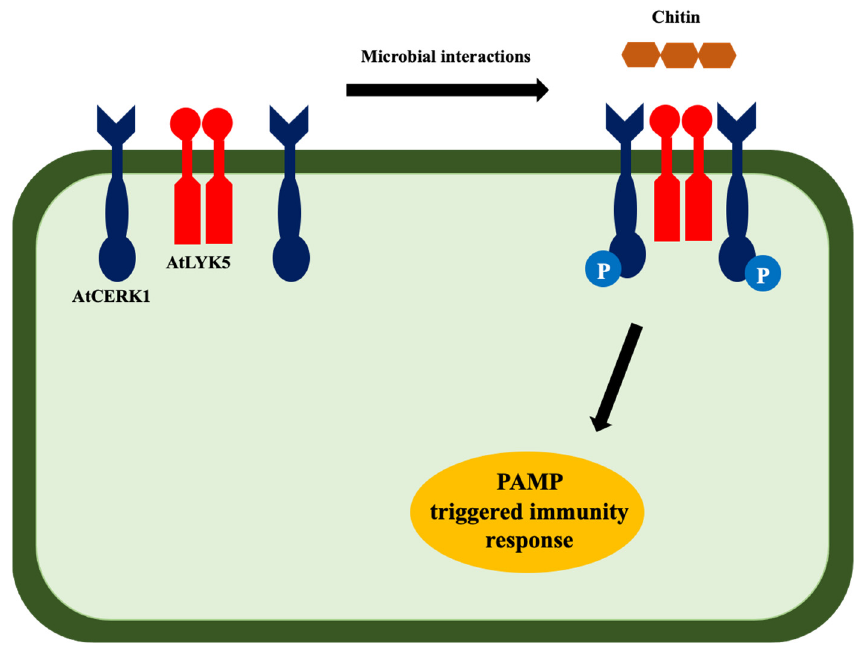
Figure 4. Chitin-triggered immunity in plants. Microbe-derived chitin activates the formation of tetramer [AtCERK1(AtLYK5)2 AtCERK1] that phosphorylates the AtCERK1 at the same time. This phosphorylation activates the PAMP-triggered immunity in plants [78].